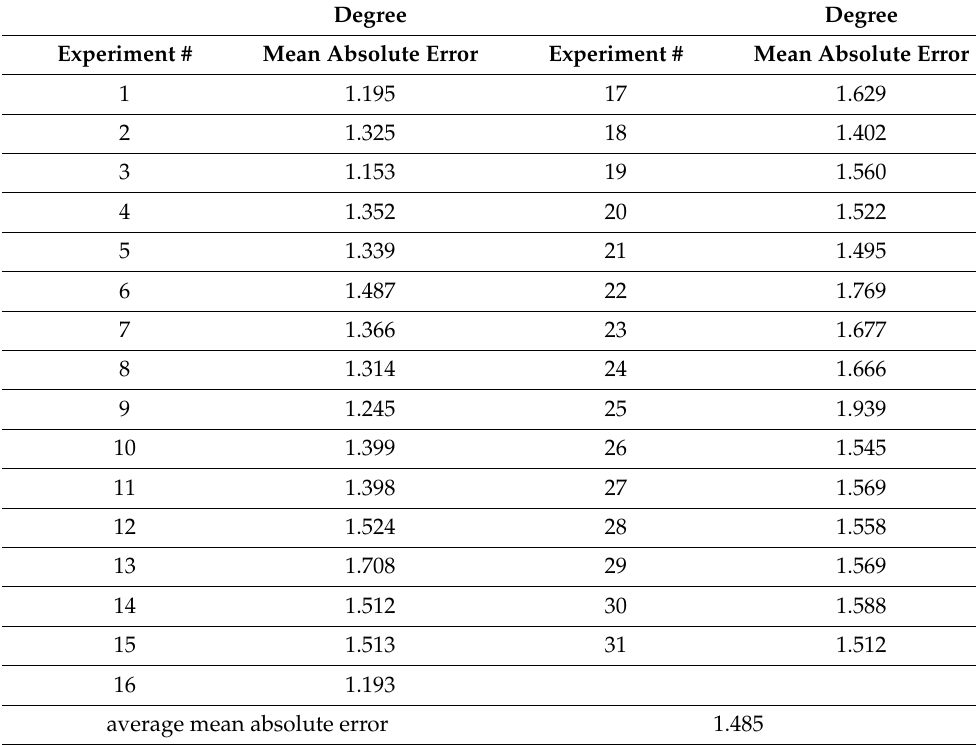
Table 4. The average mean absolute error of the quaternions obtained from the nine-axis